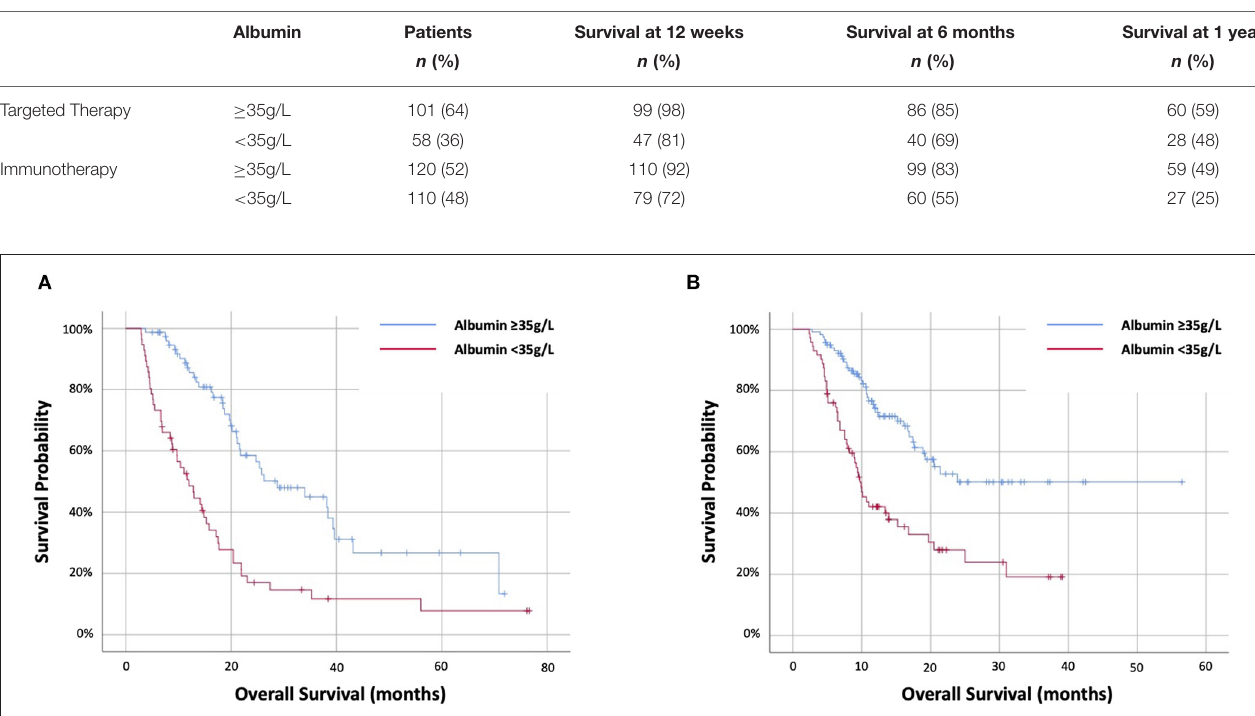
immunotherapy cohort, 98 out of 153 (64%) had PD-albumin < 35 g/L. Progressive disease-albumin was predictive of PD-OS at HR2.87 (95%CI 1.91–4.31) ( p < 0.001) and stratifying PD-OS from 1.2 (IQR 0.1–3.4) months ( < 35 g/L) to 6.8 (IQR 1.6–9.5) months ( ≥ 35 g/L) ( p < 0.001) ( Figure 3B